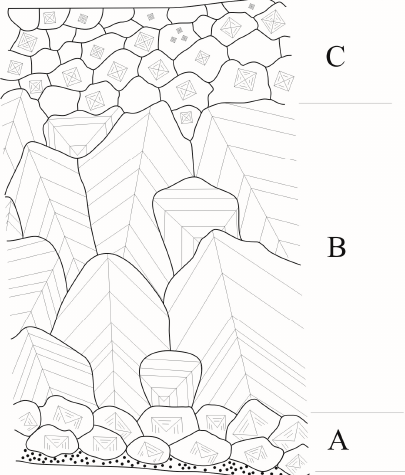
Figure 1. Sedimentation differences of halite in the context of salt deposits [8]. ( A ) fine-grained salt with relics of near-surface precipitating halite (cumulate halite). ( B ) coarse and medium-grained salt with the remnants of bottom grown halite (chevron halite). ( C ) fine-grained salt with the relicts of salting-out halite. Chevron halite (“outlined” by primary fluid inclusions) is the main and the most common form of sedimentary halite in ancient salt deposits. Other types of sedimentary halite are quite rare.